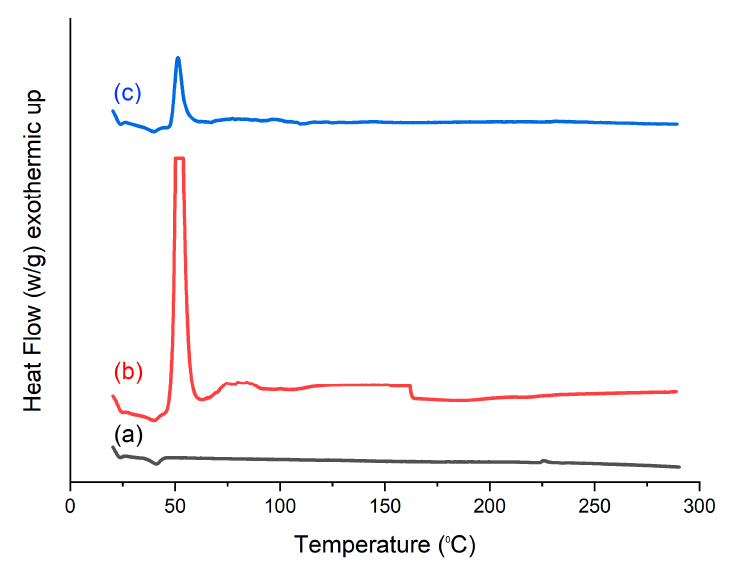
Figure 6. DSC diagrams of ( a ) epoxy and CAR in the absence of any catalyst; ( b ) a mixture of epoxy resin and CAR in the presence of HCl; and ( c ) a crushed epoxy composite containing nanocapsules with HCl.